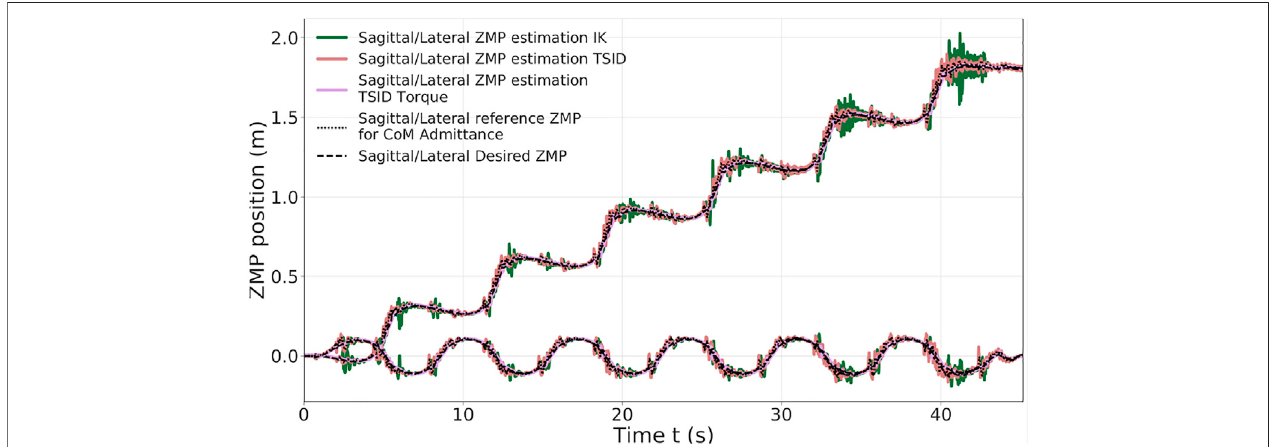
FIGURE 9 | ZMP estimation of stair